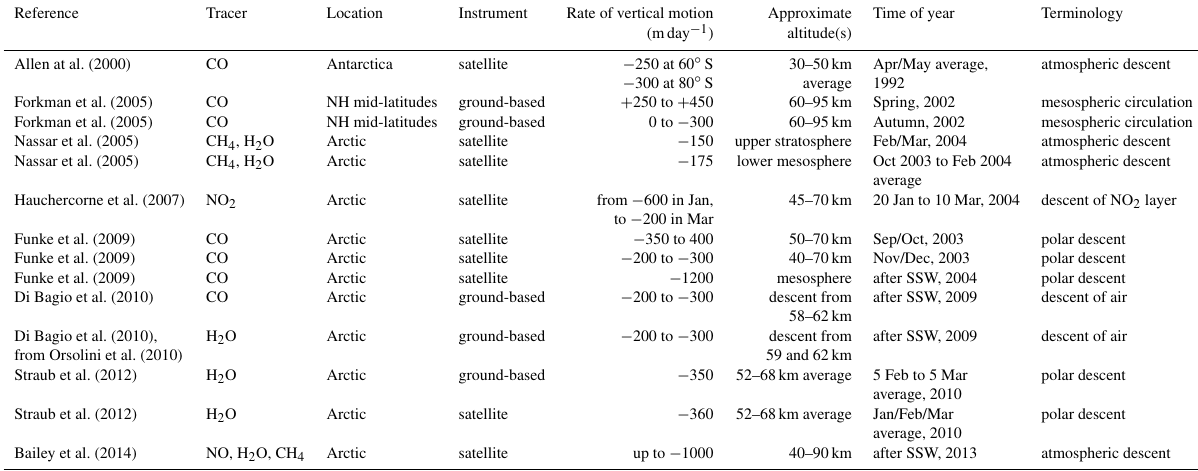
Table 1. A partial list of studies that used atmospheric tracers to derive rates of vertical air motion in the atmosphere.